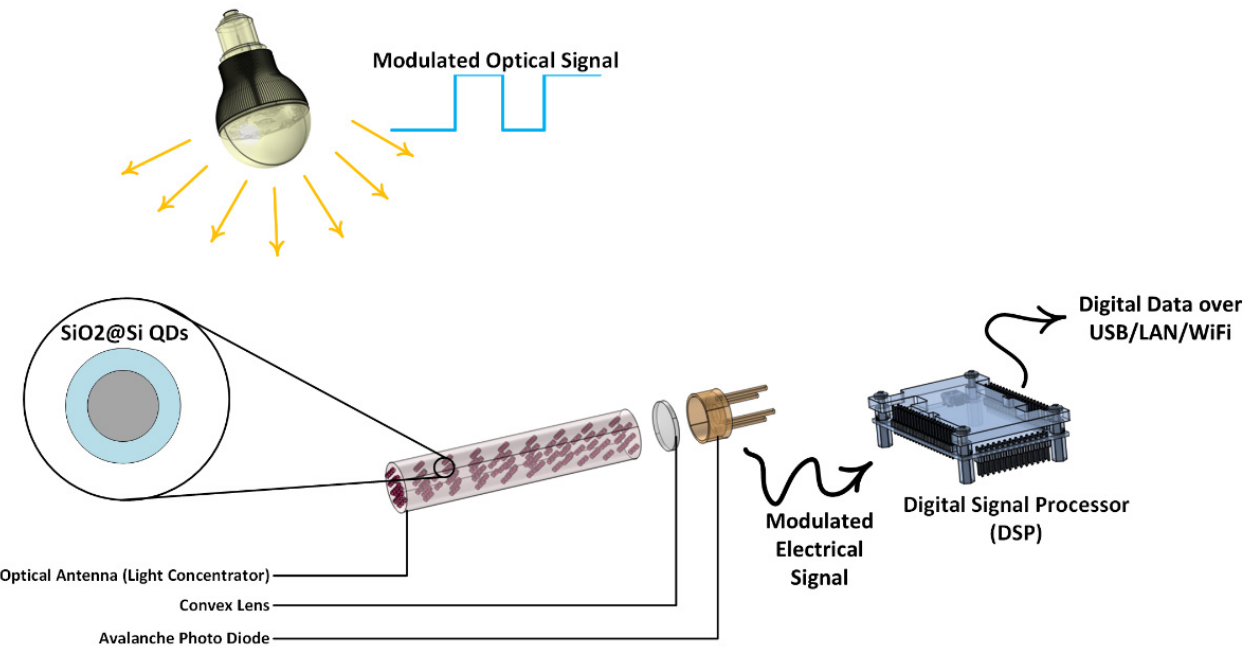
Figure 2. Schematic description of the proposed optical antenna in a VLC Setup.